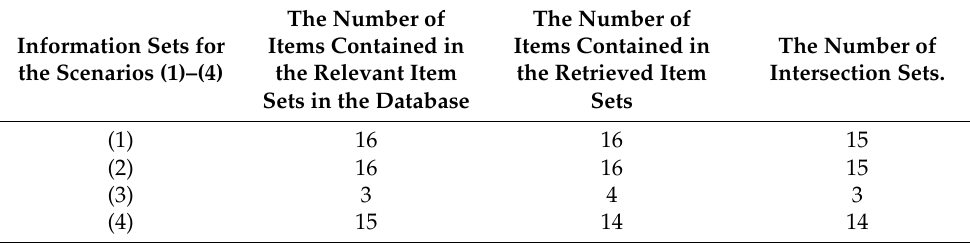
Information Sets